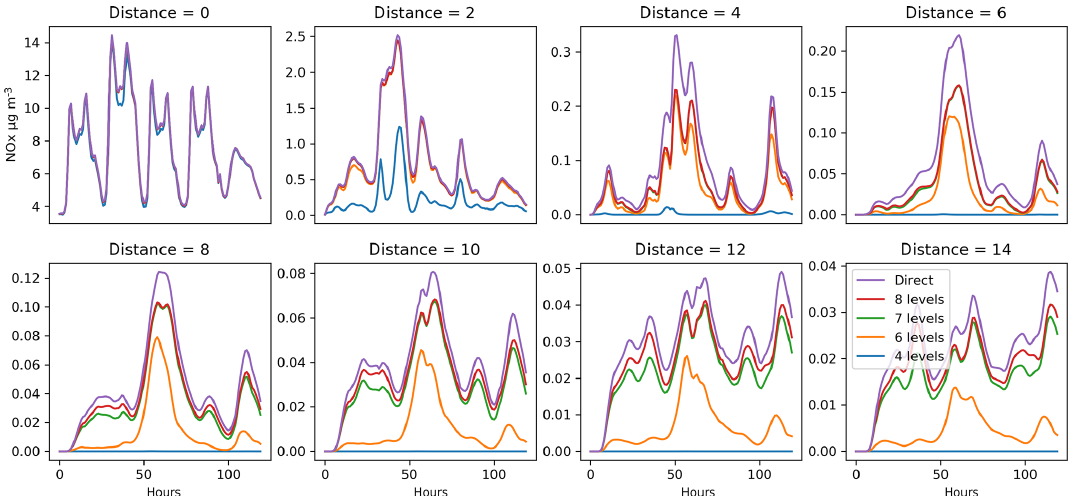
Figure 6. Concentration of NO x (µgm − 3 ). Sensitivity to the number of vertical levels is included in the local region. The distance to the source is given in numbers of grid cells (one grid cell represents 0.3 ◦ in longitude direction). The source is the Oslo agglomeration. Horizontal axis is time (120h). At a distances larger than a few grid cells, a discrepancy can be observed between the contribution calculated with the local fraction method and the direct